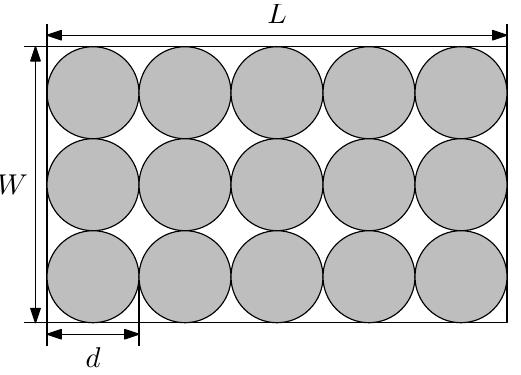
Figure 6. Representation of the arrangement of the hydrogen cylinders inside a container.